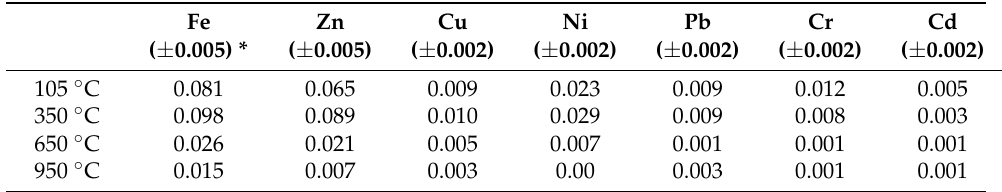
Table 4. Toxic leaching of ceramsite fired at different temperatures mg/g dried